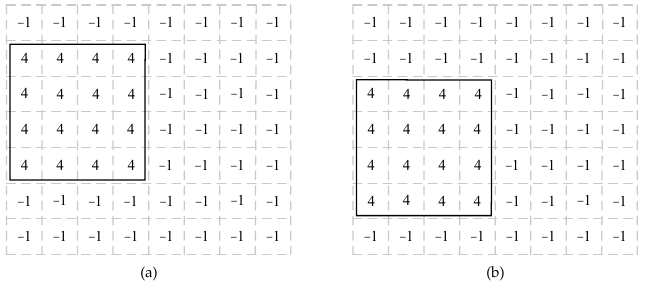
Figure 5. ( a ) An example of initial chiplet placement. ( b ) Symmetrical placement with the same mapping effect. mapping